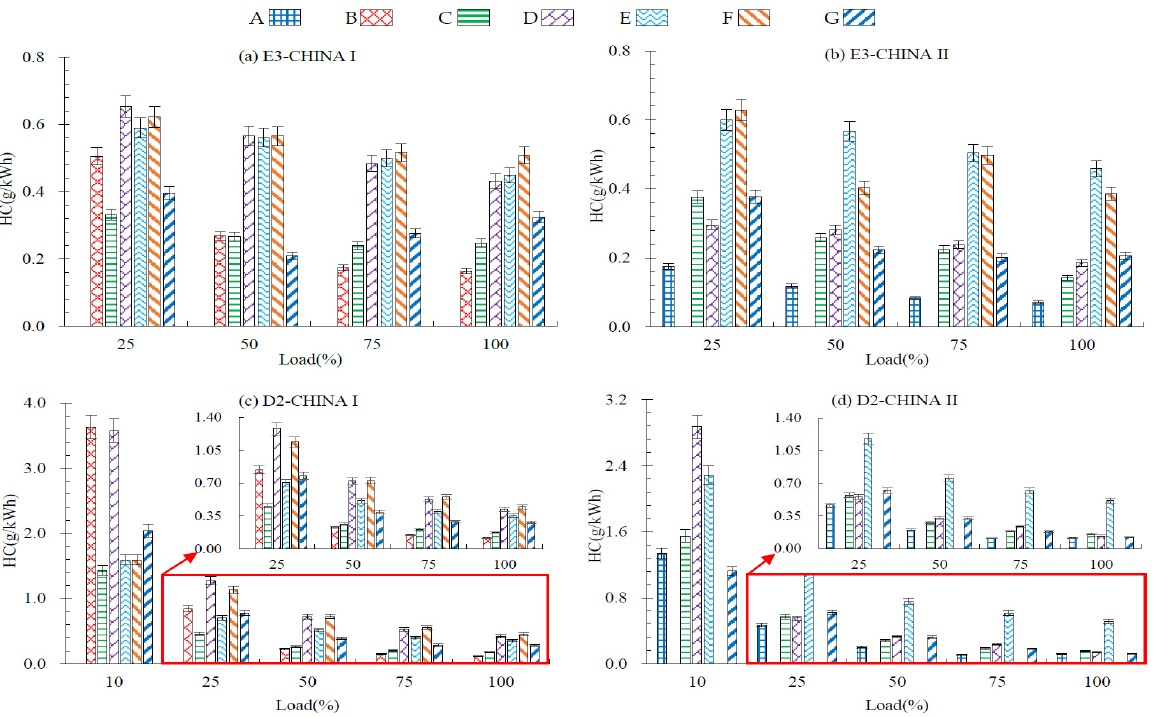
Figure 7. Relationship of HC energy-based emission factors against load. ( a ) Specific emissions in the E3 cycle at four load points under the CHINA I standard; ( b ) Specific emissions in the E3 cycle at four load points under the CHINA II standard; ( c ) Specific emissions in the D2 cycle at five load points under the CHINA I standard; ( d ) Specific emissions in the D2 cycle at five load points under the CHINA II standard.